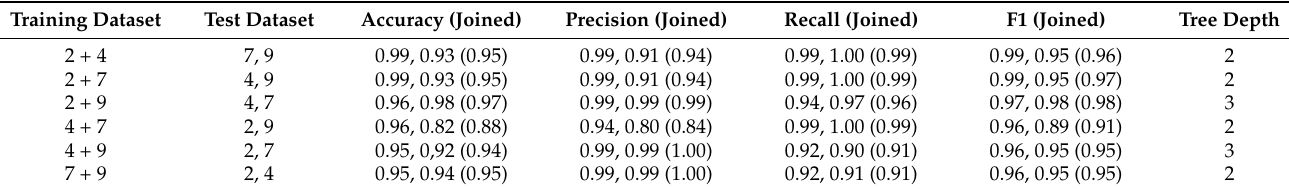
Table 6. Results using two datasets as training